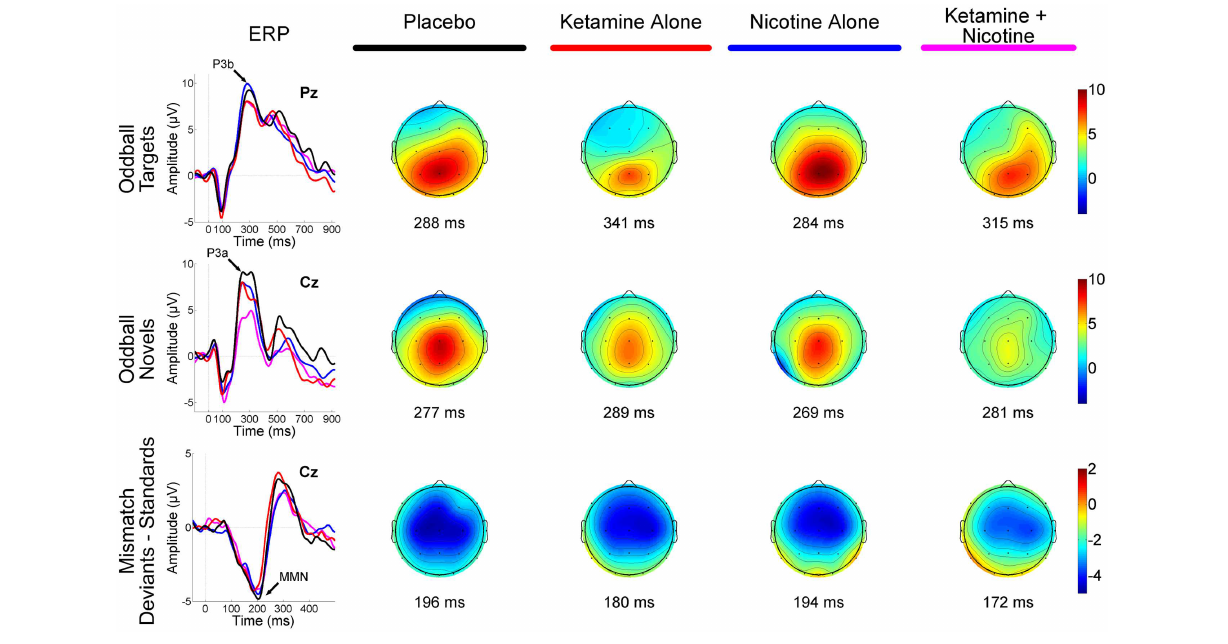
FIGURE 1 | Event-related brain potential grand average waveforms (left) and corresponding topographic maps (right) are shown for placebo (black), ketamine alone (red), nicotine alone (blue), and ketamine + nicotine (magenta) days . ERPs, overlaid for each test day, are shown to oddball targets at Pz (top row), to oddball novels at Cz (middle row), and to difference waveforms (deviants-standards) at Cz.The oddball target elicited a P3b, the oddball novel elicited a P3a, and the